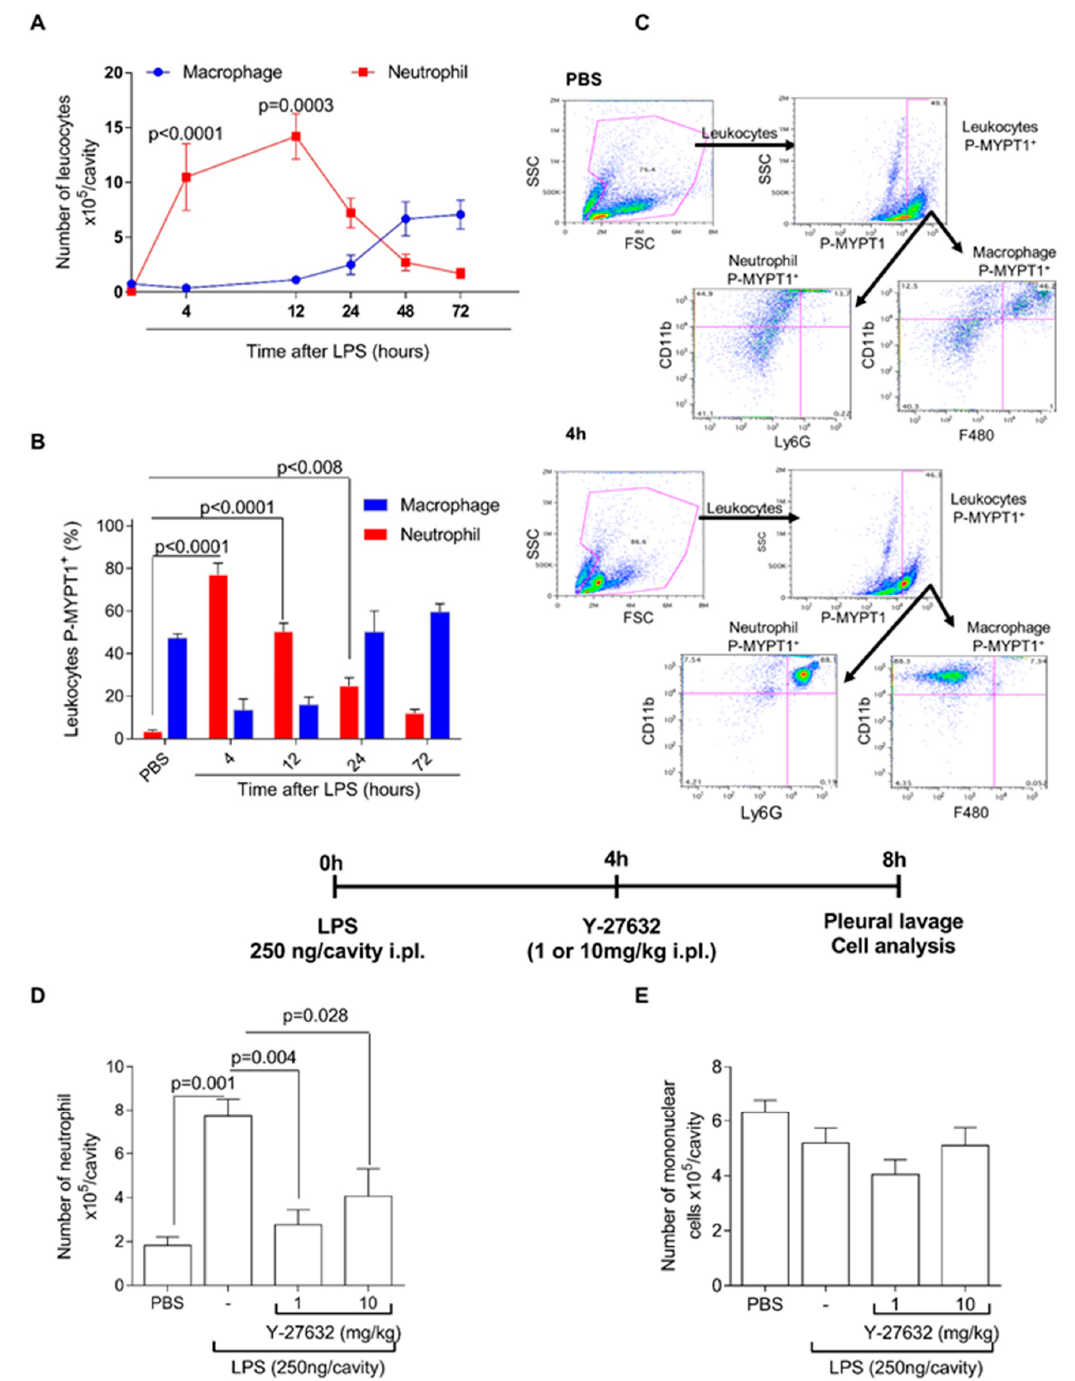
Figure 1. Time course of Rho-associated kinase (ROCK) activity during productive phase of lipopolysaccharide-induced pleurisy and the effects of ROCK inhibition. Mice were injected with phosphate buffered saline (PBS) or lipopolysaccharide (250 ng / cavity, i.pl.), and the number of leukocyte (neutrophils and macrophages, A ) were evaluated at various times by flow cytometer. Data were collected with FACSCanto II flow cytometer and analyzed with FlowJo software. P-MYPT-1 expression was evaluated by flow cytometer at various times and represented as percentage of p-MYPT positive ( B ). Data were collected with BD Accuri™ C6 cytometer and analyzed with FlowJo software. Representative dot plots of gate strategy for the flow cytometric analysis ( C ). Mice were injected with PBS or LPS (250 ng/cavity, i.pl.), and 4 h later received two different dose of Y-27632 (1